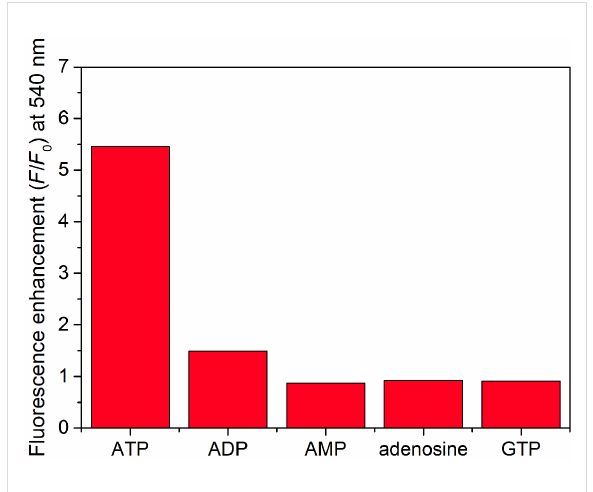
Figure 5: Fluorescence enhancement ( F / F 0 ) values of UHF (1.0 μ M) upon addition of different nucleotides at 540 nm (excitation: 470